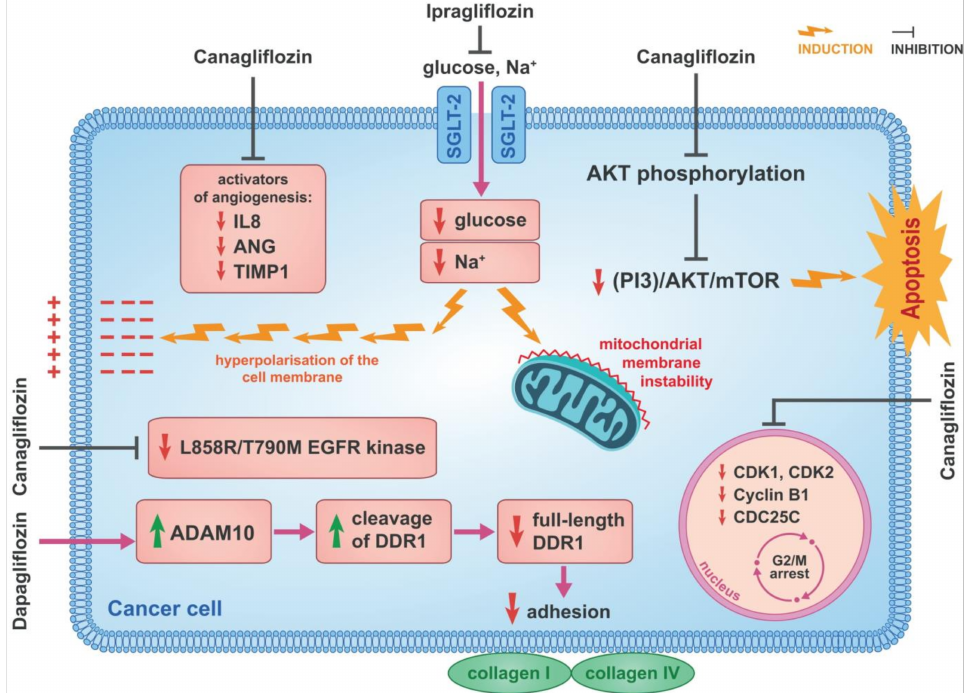
Figure 3. The mechanisms of anti-cancer action of SGLT-2 inhibitors. Canagliflozin induces G2/M arrest in Huh7 and HepG2 cells. In these cell types, the effects of canagliflozin on cycle-related genes were studied and the downregulation of genes such as CDK1, CDK2, Cyclin B1 and CDC25C was con- firmed. Canagliflozin also inhibits AKT phosphorylation and by inhibiting the (PI3K)/AKT/mTOR signalling pathway induces apoptosis in Huh7 and HepG2 cells. Canagliflozin inhibits such activators of angiogenesis as IL-8, ANG and TIMP-1 in HCC cells which produce increased amounts of these activators. These activators of angiogenesis are involved in the growth and progression of HCC. It has been confirmed that ipragliflozin has an antiproliferative effect in breast cancer cells. Through the inhibition of cellular sodium influx, ipragliflozin induces both a hyperpolarisation of the cell membrane and mitochondrial membrane instability in breast cancer cells. It has been confirmed that canagliflozin inhibits L858R/T790M EGFR kinase and this is the mechanism of its anticancer activity in lung cancer cells. Dapagliflozin has been confirmed to reduce the amount of full-length DDR1 protein. It has also been shown to directly increase the activity of ADAM10, which induces the cleavage of DDR1 in HCT116 cells. In this way dapagliflozin disrupts the adhesive abilities of